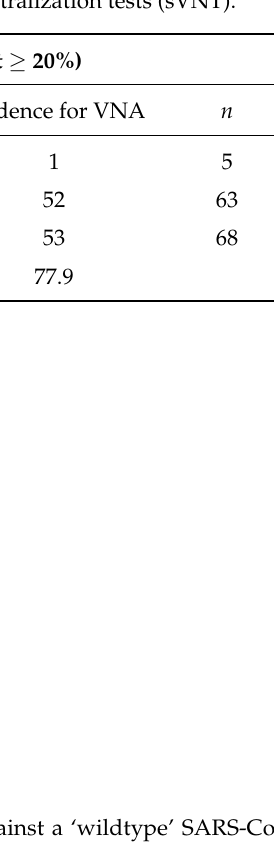
Table 3. Qualitative agreement of results obtained with both surrogate virus neutralization tests (sVNT).